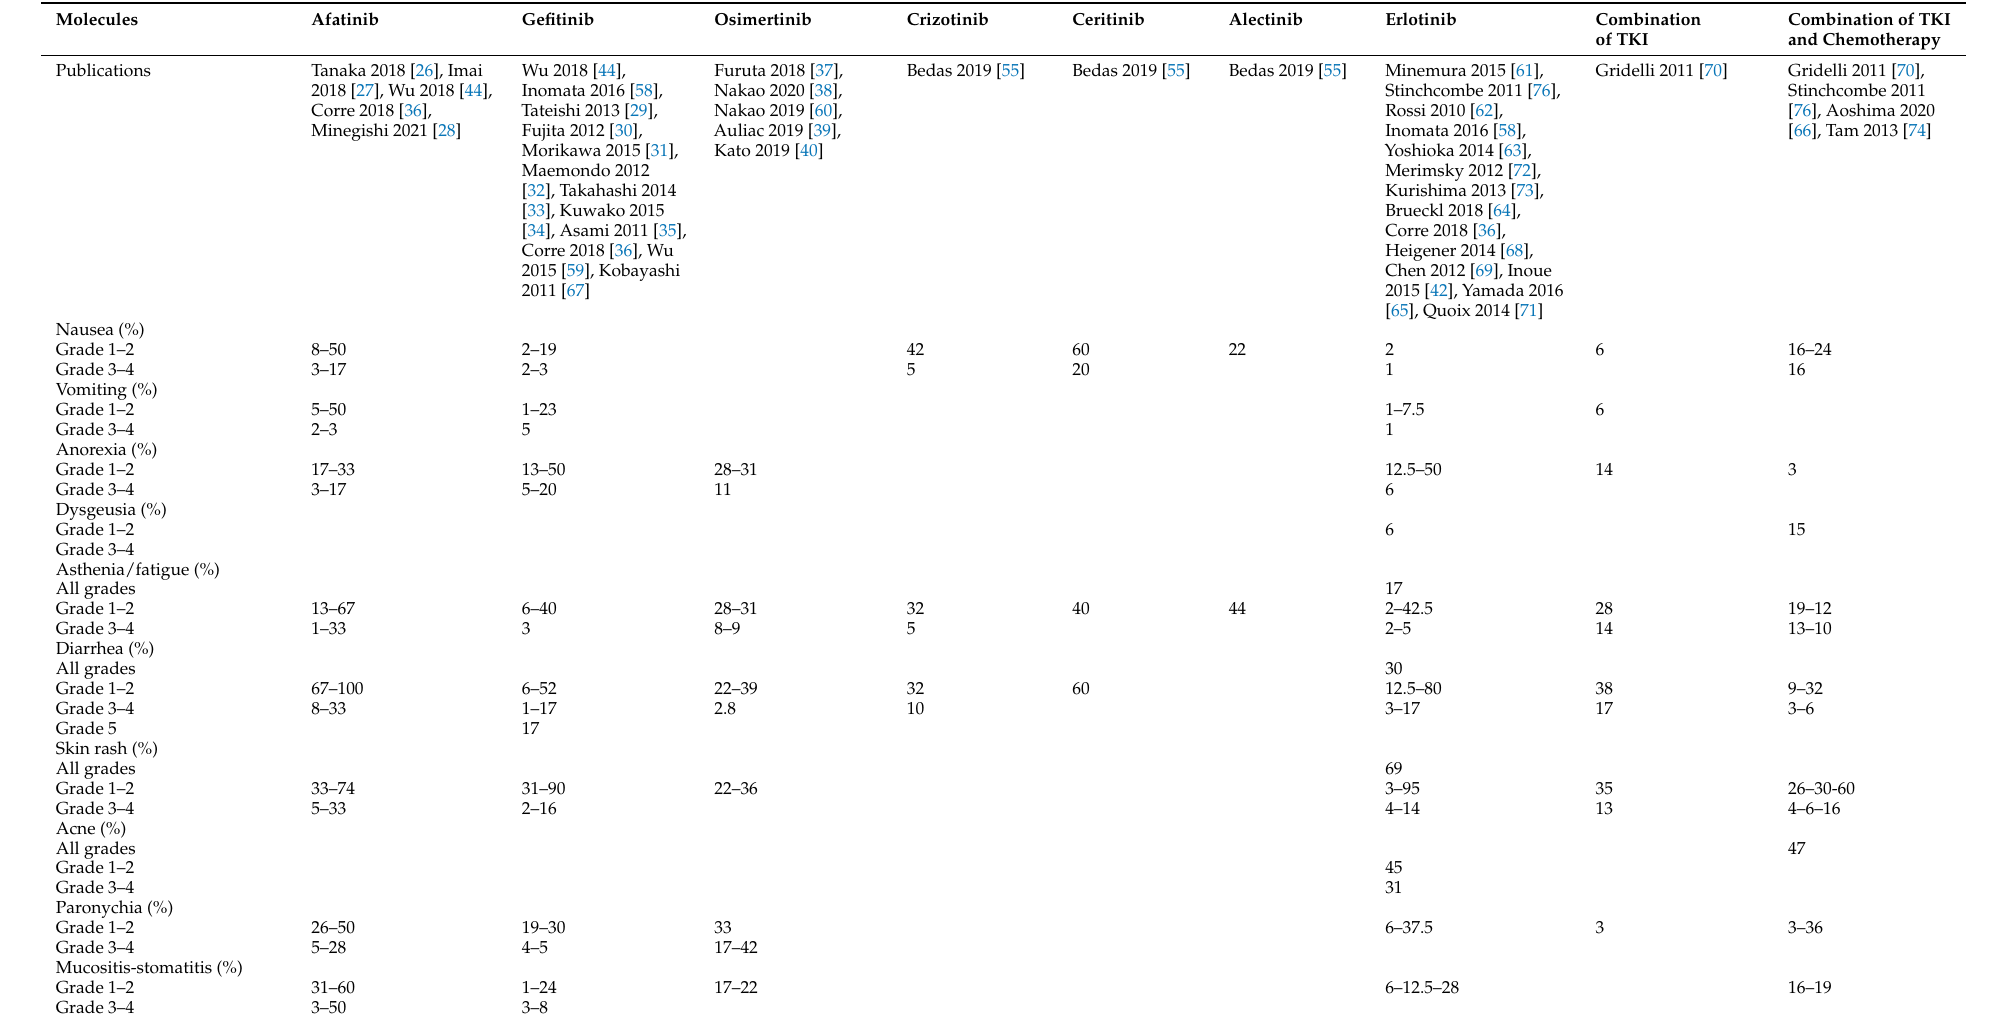
Table 5. Prevalence of non-hematological and non-biological toxicities according to targeted therapies in trials, cohorts, or trial subgroup post-hoc analysis.